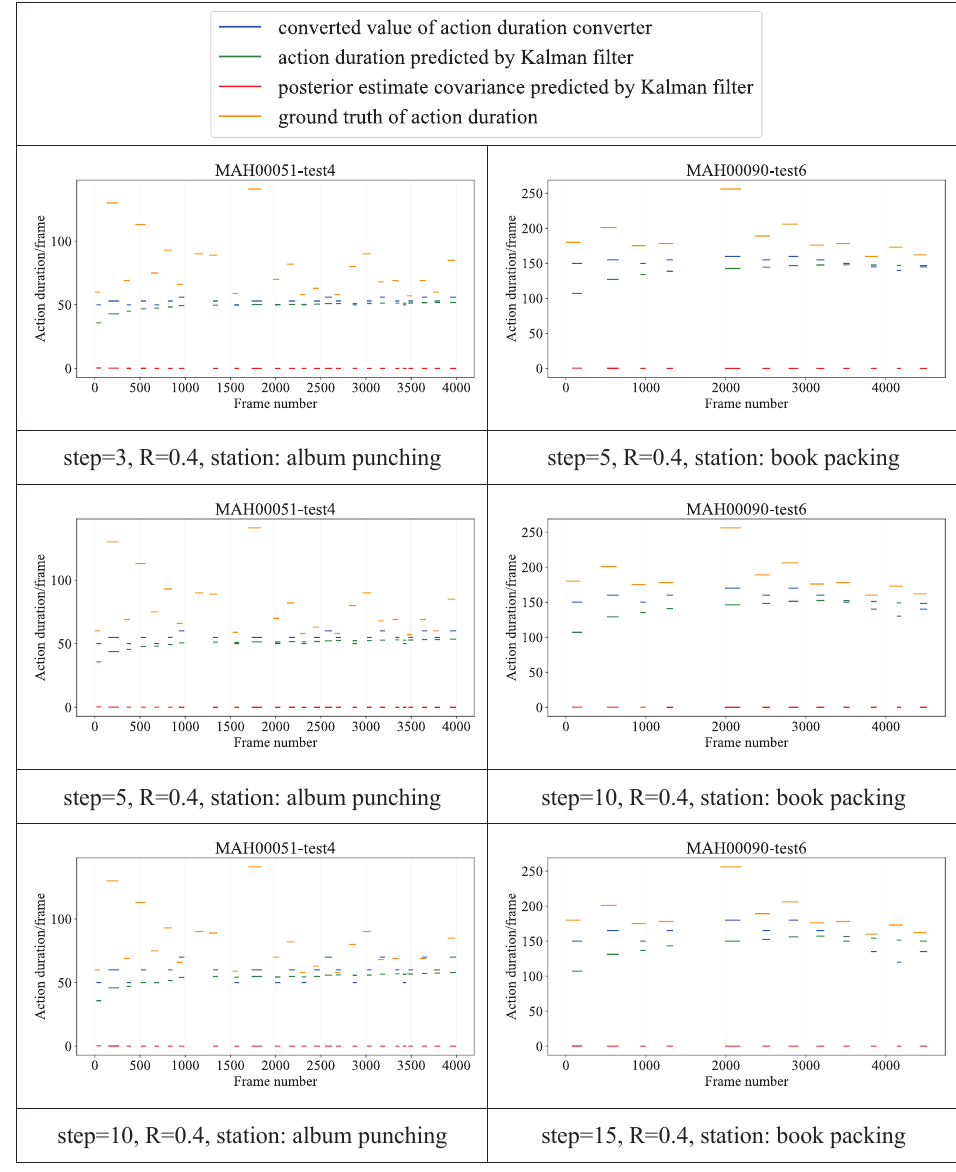
Figure 10. Influence of step on the results of adaptive parameter